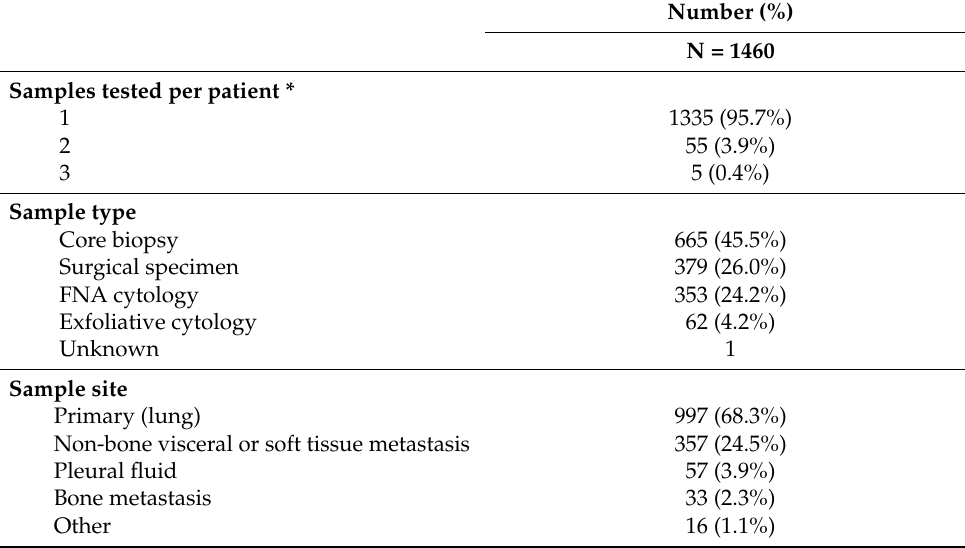
Table 2. Sample characteristics (N = 1460